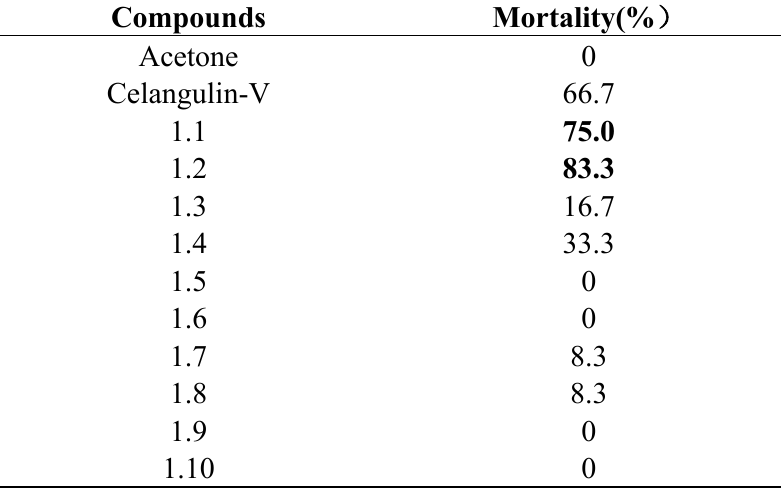
Table 4. Insecticidal activities of Celangulin-V